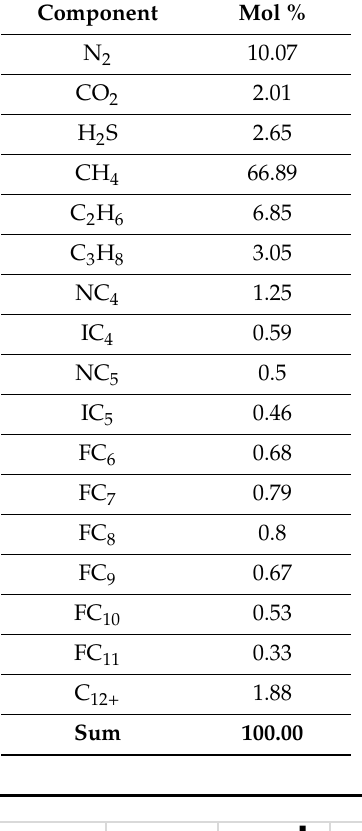
Table 2. Fluid composition adopted in this work [32–34].